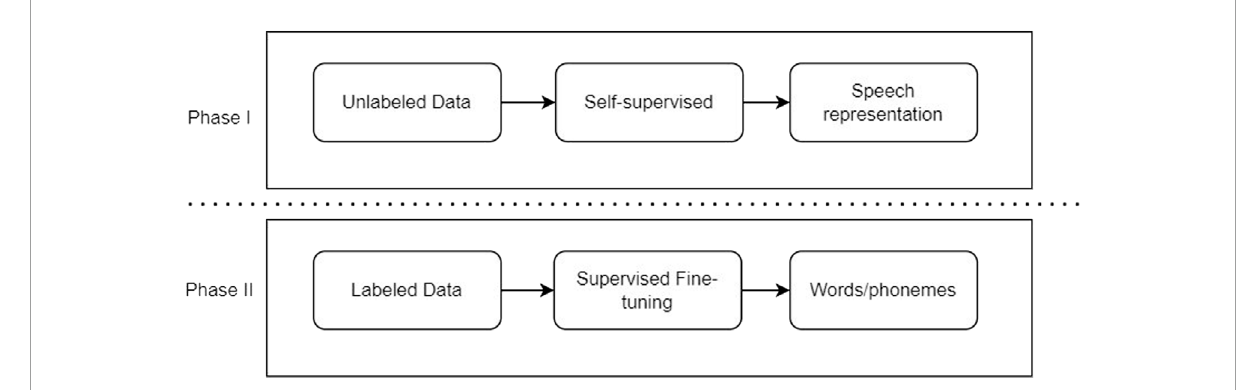
FIGURE 6 Self-supervised model.